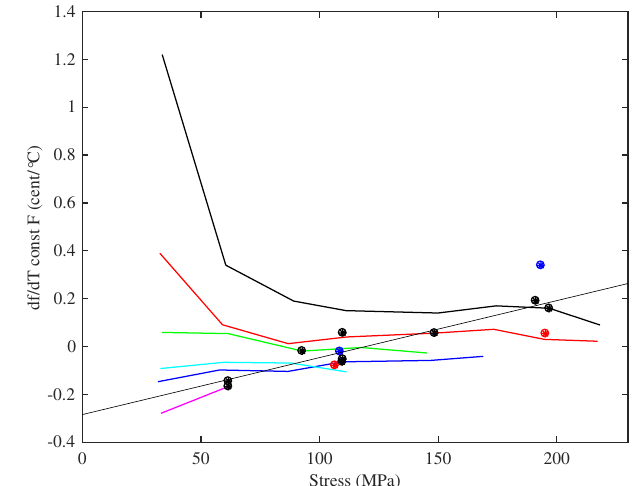
Figure 15. The thermal tuning sensitivity, plotted against stress, for the strings held at constant tension. The y -axis shows the rate of change of fundamental frequency f 1 with temperature T . Colours identify the di ff erent tested strings (Table 1): black (8:A6), red (14:A5), blue (5:A4), green (23a:A3), cyan (29:E3), magenta (10b:A2). The fitted line ( r 2 = 0.895) was matched to the data (black circles) for the operating points of the Bowbrand strings tested at the usual humidity levels (around 55–65% RH at 20 ◦ C). Blue circles show Pirastro strings; red circles show tests at low humidity (around 20–26% RH at 20 ◦